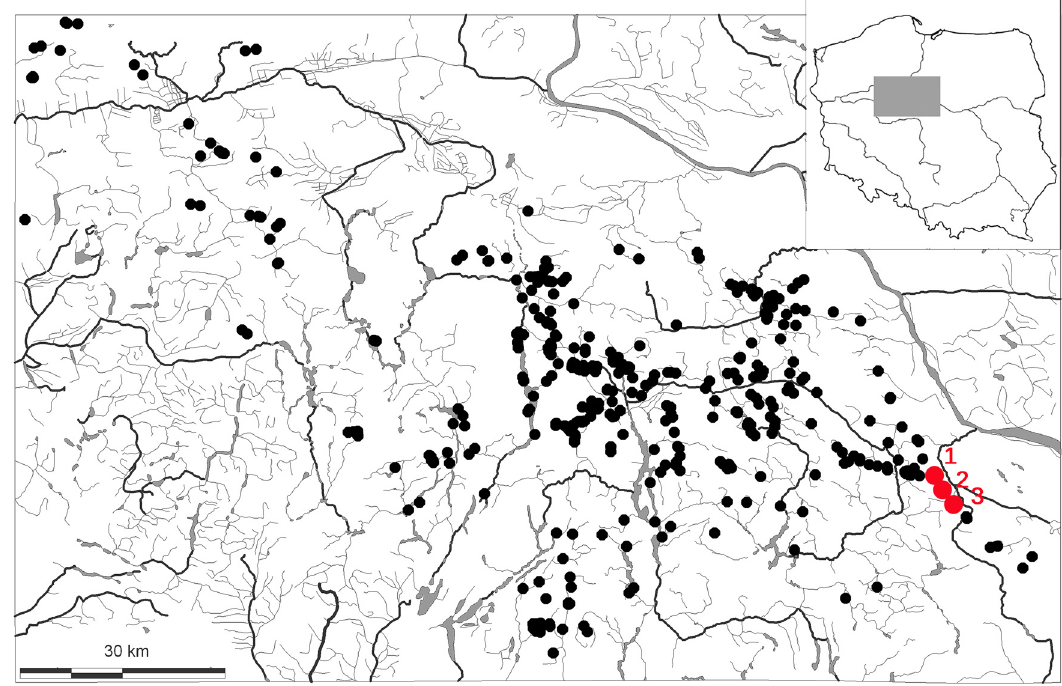
Figure 1: LBK settlement in Kuyavia. ( 1 ) Smólsk microregion, ( 2 ) Kruszyn microregion, and ( 3 ) Ludwinowo